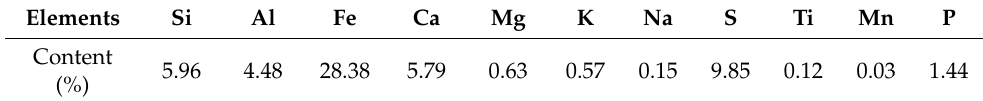
Table 3. Contents of elements of solids in groundwater (from [19]) collected from plugging horizon.